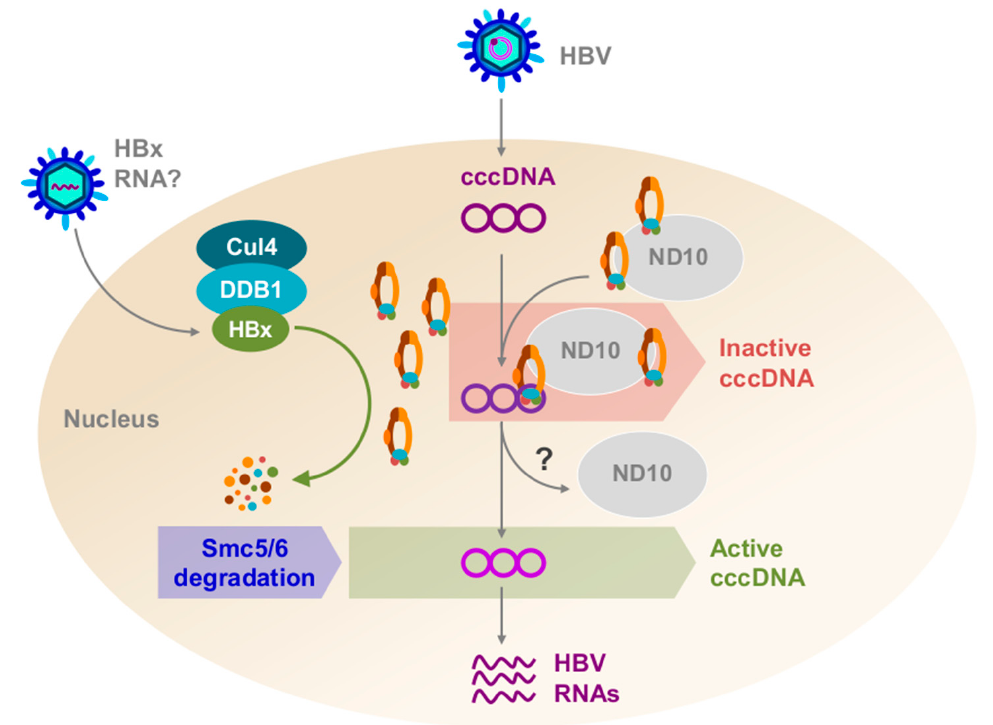
Figure 2. A model depicting the role of hepatitis B X protein (HBx) in hepatitis B virus (HBV) infection of a human hepatocyte. Relaxed-circular DNA (rcDNA) and possibly HBx RNA are deposited within the cell, and HBx protein may be translated from the HBx RNA. rcDNA is converted to covalently-closed circular DNA (cccDNA) and HBx binds Cullin4–DNA-damage binding protein1 (Cul4–DDB1). Structural maintenance of chromosomes 5/6 (Smc5/6) co-localizes with nuclear domain 10 (ND10) bodies. Cul4–DDB1–HBx targets Smc5/6 for ubiquitination. Smc5/6 is subsequently degraded by the proteasome, and cccDNA can now be